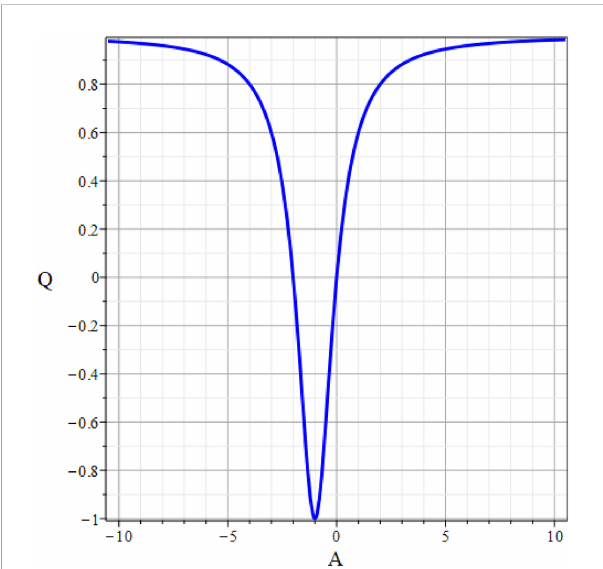
FIGURE 2 Nondimensional attenuation rate Q from (22) for deep-water waves as a function of the nondimensional real Robin parameter A = R r = g